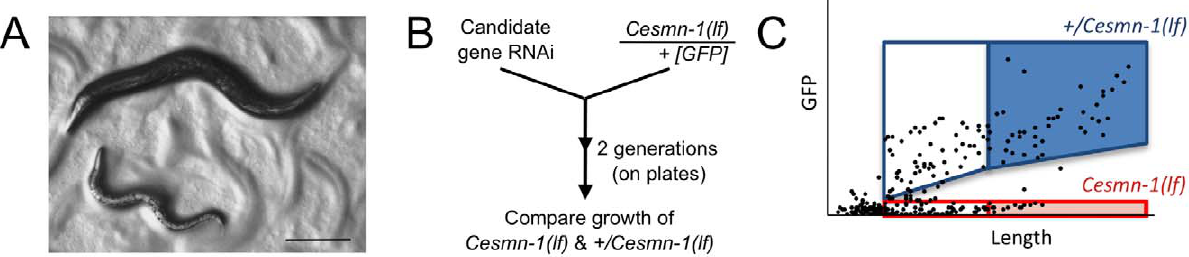
Figure 1. Survival and average length of Cesmn-1(lf) animals is decreased. Homozygous loss of Cesmn-1(lf) results in slower growth and most animals die during larval stages. Animals that reach the adult stage are short-lived and sterile. A) Image of age-matched heterozygous hT2(lethal)[myo-2p::GFP]/Cesmn-1(lf) ( + /Cesmn-1(lf) , described in text) and homozygous Cesmn-1(lf) individuals (below). Scale bar indicates 150 microns. B) To test the impact of candidate modifier genes on growth rates and size, a C. elegans growth assay was established. + /Cesmn-1(lf)